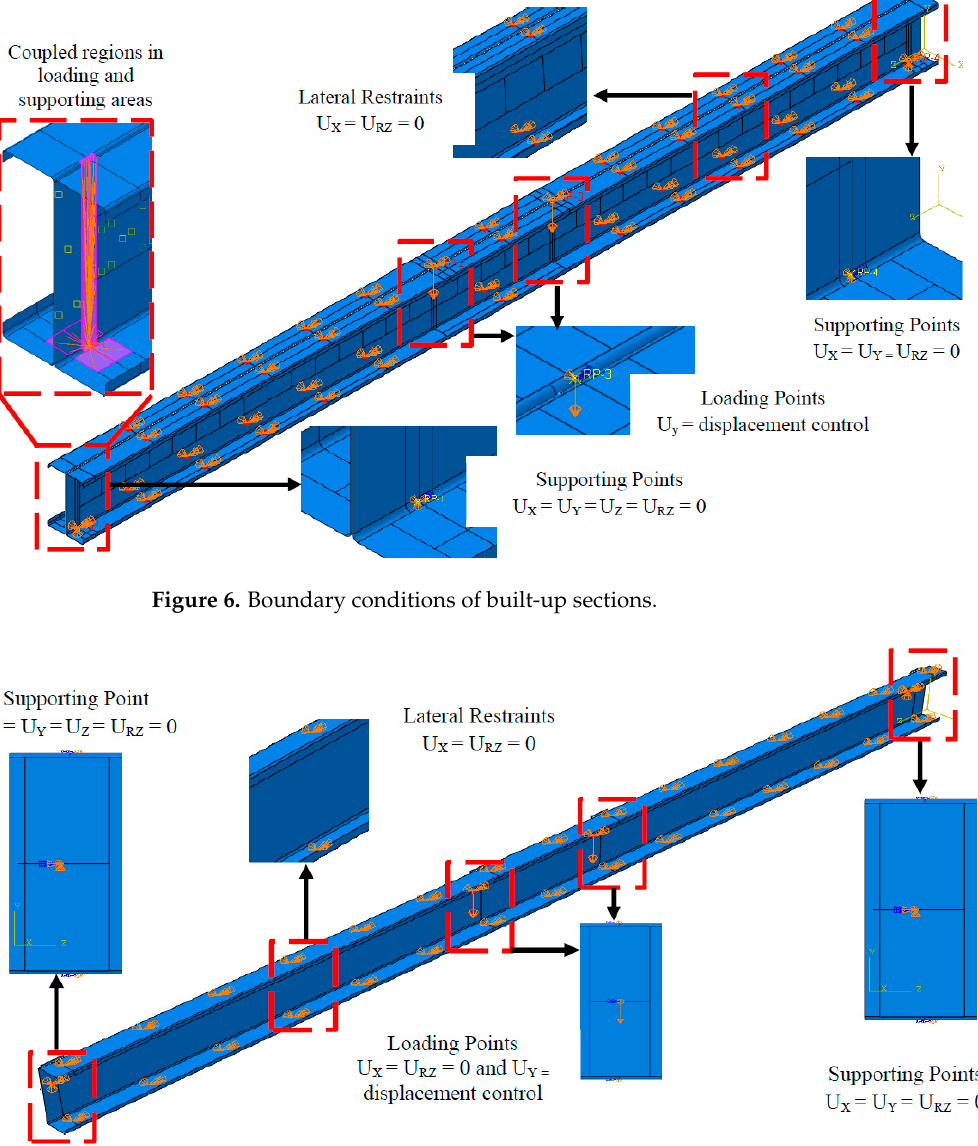
Figure 7. Boundary conditions of single sections.